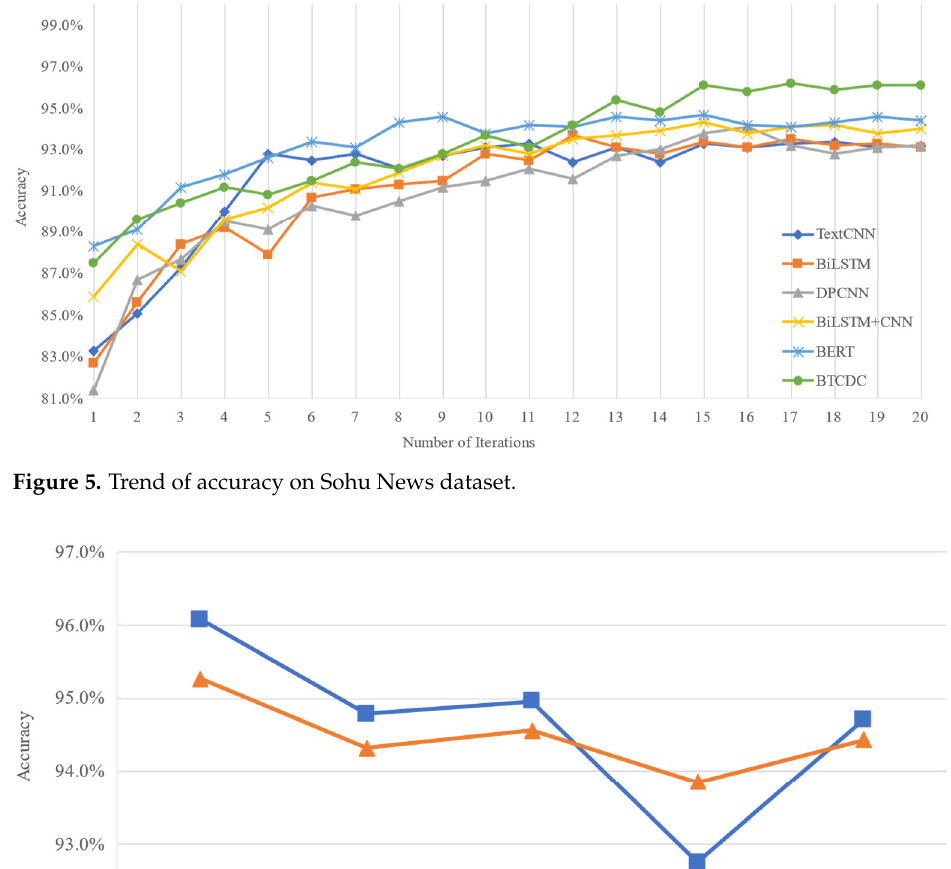
Figure 5. Trend of accuracy on Sohu News dataset.